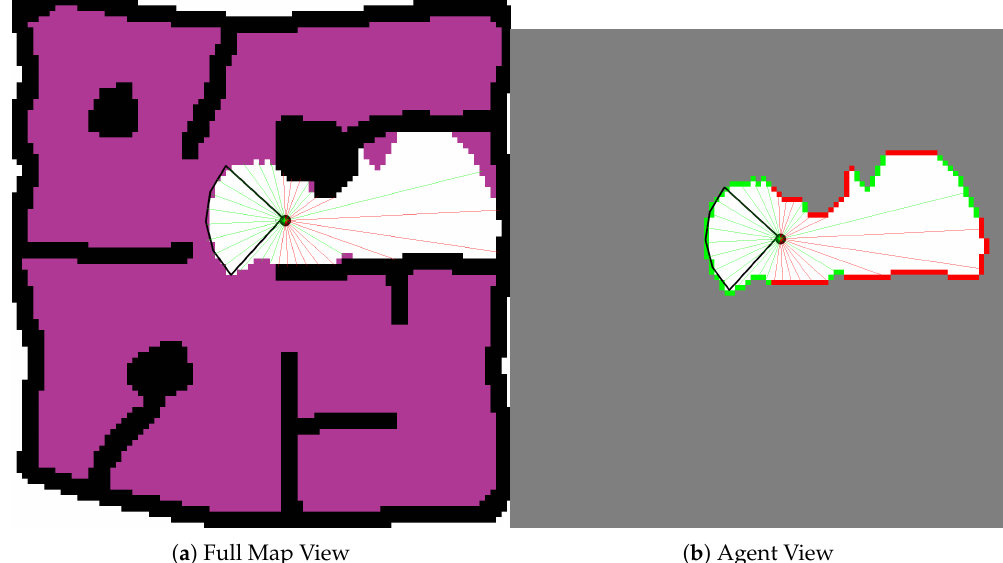
Figure 6. Full Map View vs. Agent View. Black Cells : Obstacle Cells, White Cells : Explored Empty Space Cells, Purple Cells : Unexplored Empty Cells, Grey Cells : Unexplored Area, Red Cells : Observed Obstacle Cells, Green Cells : Safe Edges of Unexplored Region, Black Cone : Field of View of Agent’s Sensor, Red Lines : Obstacle Distance Readings, Green Lines : Safe Distance Readings, Circle : UAV.